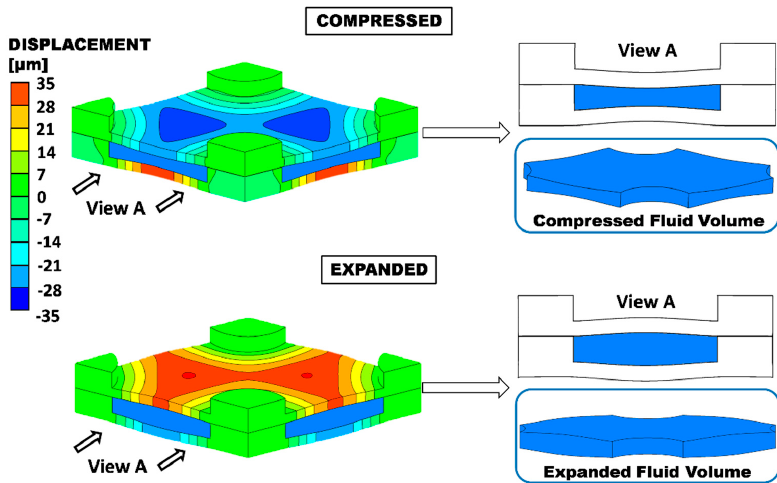
Figure 5. Deformations for P / H = 10 in both the compressed and the expanded cases at TMP = ±0.4 bar. The quantity shown is the displacement in the direction orthogonal to the undeformed membranes. The corresponding deformed configuration of the fluid volume is shown in the insets on the right.